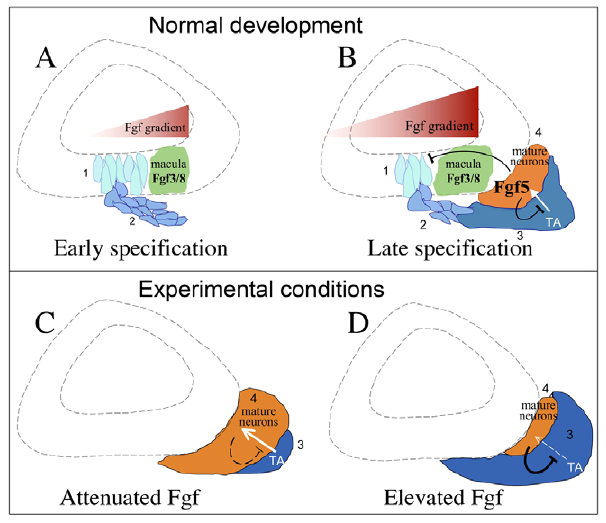
Figure 10. Model for regulation of SAG development by Fgf. (A) Neuroblast specification at early stages. A moderate level of Fgf3 and Fgf8in a gradient generated by the utricular macula specifies neuroblasts in the floor of the otic vesicle (step 1), and nascent neuroblasts quickly delaminate from the otic vesicle (step 2). (B) As development proceeds, neuroblasts establish a pool of transit-amplifying (TA) progenitors (step 3), which eventually differentiate into mature neurons and express Fgf5 (step4).Risinglevelsof neuronalFgf5, combinedwith Fgf3 andFgf8from the growing utricular macula, exceeds an upper threshold that serves to terminate specification of new neuroblasts within the otic vesicle. Neuronal Fgf5 also slows differentiation of progenitors into mature neurons. (C, D) At stages immediately following establishment of the transit-amplifying pool, experimental attenuation of Fgf signaling promotes maturation of neurons at the expense of progenitors (C) whereas elevating Fgf inhibits maturation, expanding the size of the transit-amplifying pool